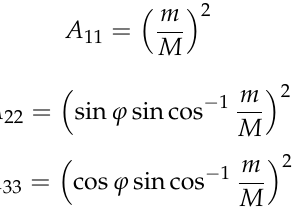
Figure 5. The simulated fibre orientation tensor component in direction 1 (A 11 ) in the longitudinal section. However, this representation was incapable of comparing the results to the real fibre orientation. Instead, the diagonals of the fibre orientation tensor were applied in a specific cross-section and were presented as a function of distance from the midplane. During the experimental investigation, sections were prepared from the injection-moulded door handle and, on the 8 × 15 mm slices, the elliptic projection of the GF sections was examined with optical microscopy, and the minor (m) and major (M) axes and the angle of the major axis ( ϕ ) (Figure 6) [16] were measured. With the help of these results, the orientation was determined with Equation (1) in the flow direction (A 11 ), with Equation (2) in the width direction (A 22 ) and with Equation (3) in the height direction (A 33 ) [31]. A 11 showed the oriented fibres’ ratios in the direction of axis 1, A 22 showed the oriented fibres’ ratios in the direction of axis 2 and A 33 showed the oriented fibres’ ratios in the direction of axis three. The sum of these variables (A 11 , A 22 and A 33 ) had to be